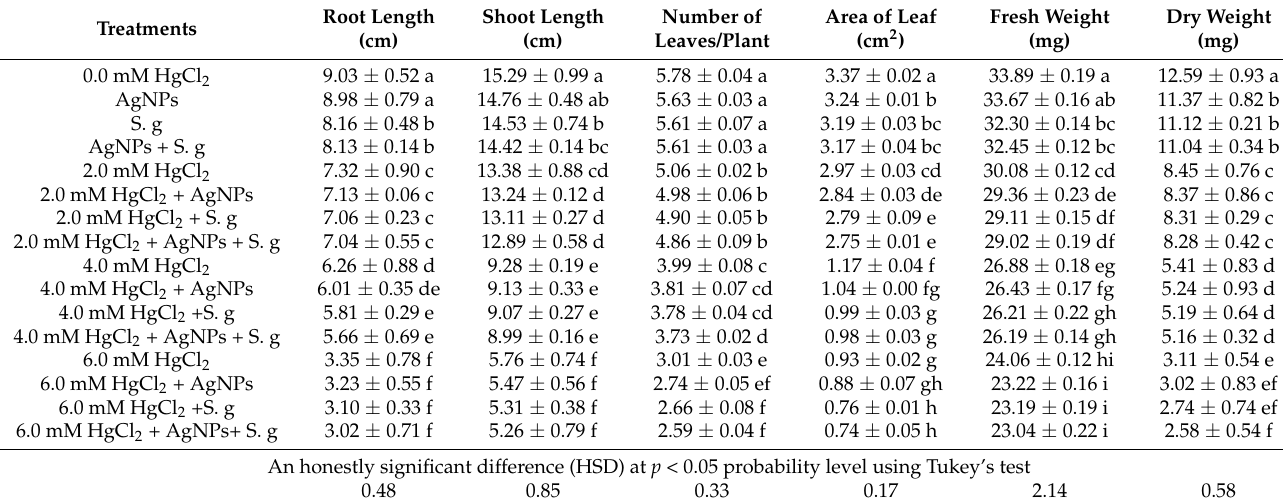
Table 1. Effect of AgNPs, Sphingobacterium ginsenosidiumtans (S. g), and their combination on Trigonella foenum-gracum L. plant growth parameters under HgCl 2 stress (0, 2, 4, and 6 mM). Treatments